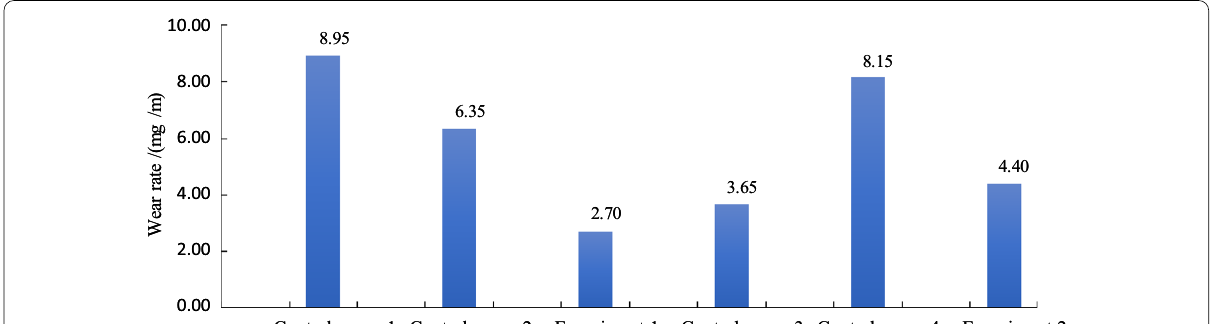
Figure 17 Comparison of experimental average wear